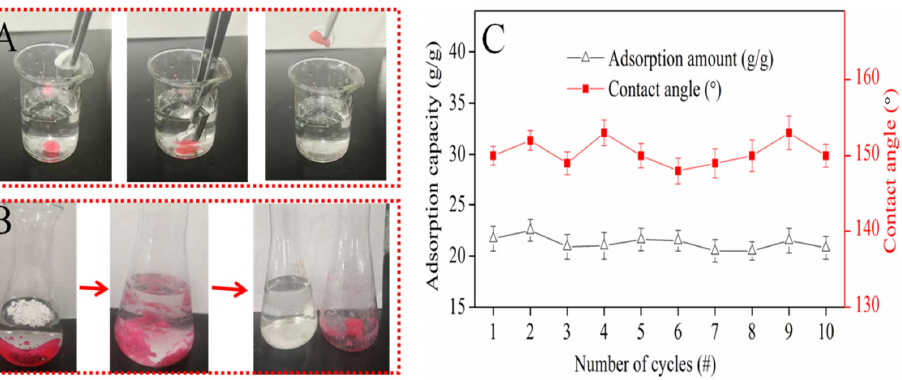
Figure 5. ( A ) CSE picks up oil underwater; ( B ) adsorption dichloromethane process; ( C ) recycling adsorption performance.